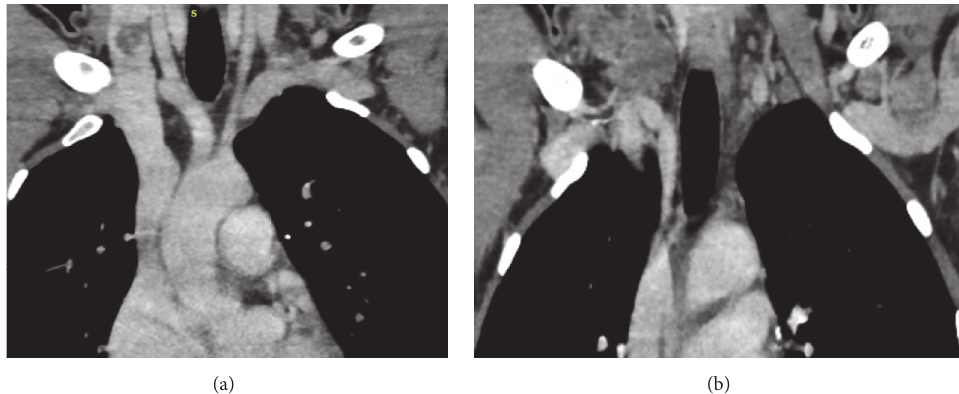
Figure 5: Coronal CECT neck showing right IJV thrombus and matted lymph nodes posterior to right CCA and IJV.